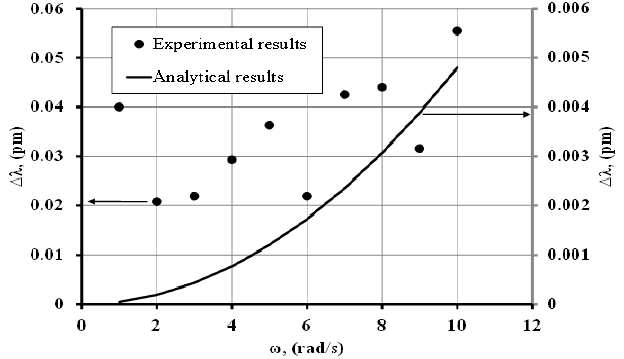
Figure 6. Comparison of experimental results with analytical prediction for a (10:1) PDMS microsphere.